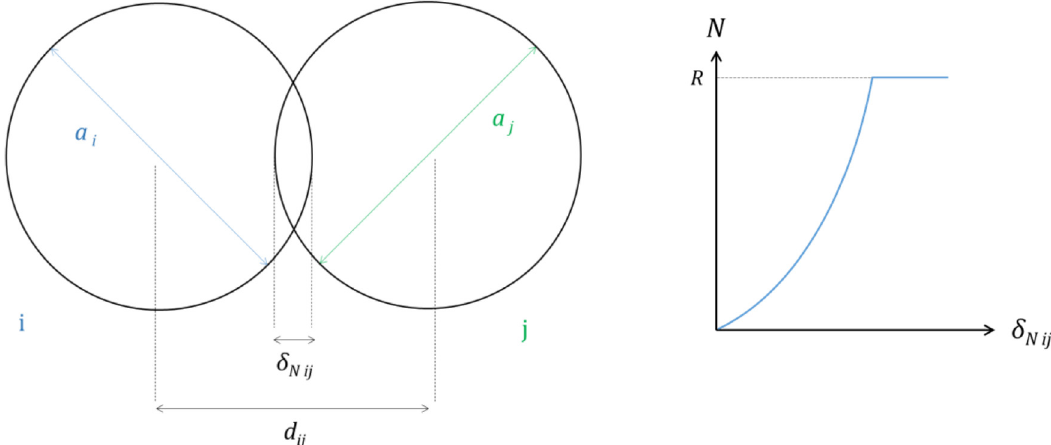
Fig. 4. Left: contact between two pellets i and j of diameter a i and a j , distance between centres d ij , and normal de fl ection d N ij . Right: evolution of normal force as a function of normal de fl ection.